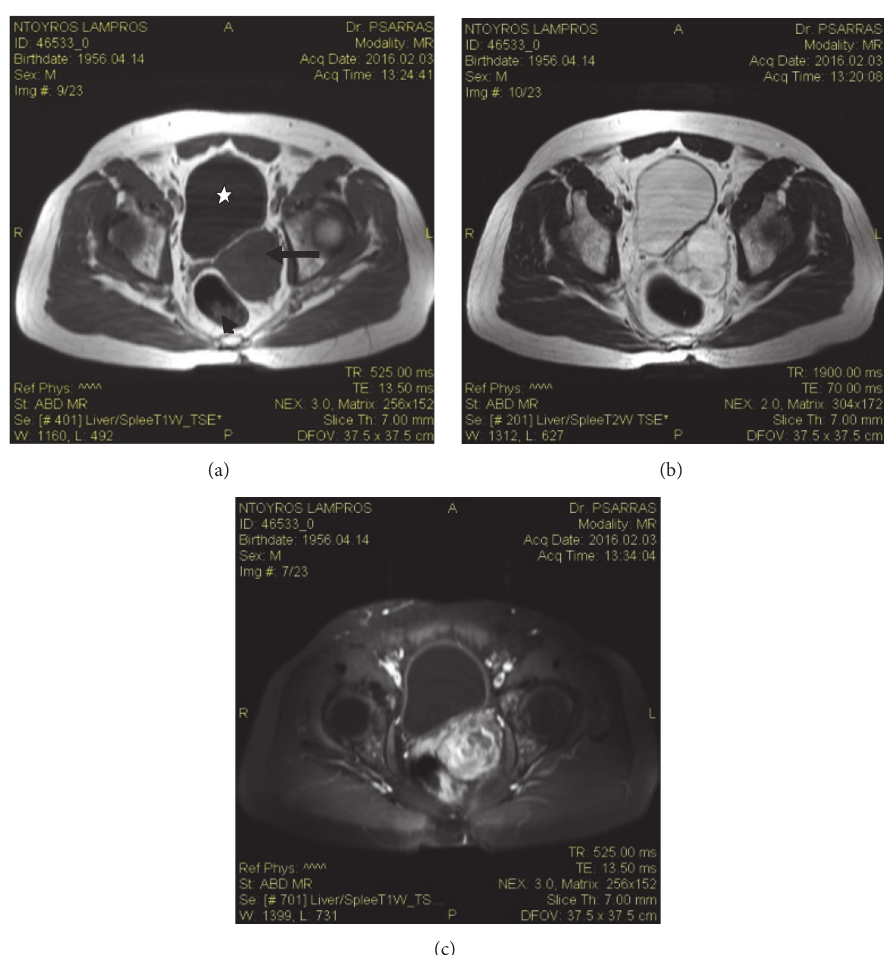
Figure 2: (a) T1-weighted axial MRI image demonstrating a fusiform, lobed, well-circumscribed, hypointense lesion (arrow) with regular borders, compressing the rectum (arrowhead) and the posterior wall of the urinary bladder (white star). (b) T2-weighted axial MRI image showing the lesion having hyperintense signal and containing thin septa. (c) T1-weighted postcontrast axial MRI demonstrating heterogeneous enhancement of the lesion’s lobules after intravenous administration of paramagnetic contrast agent.